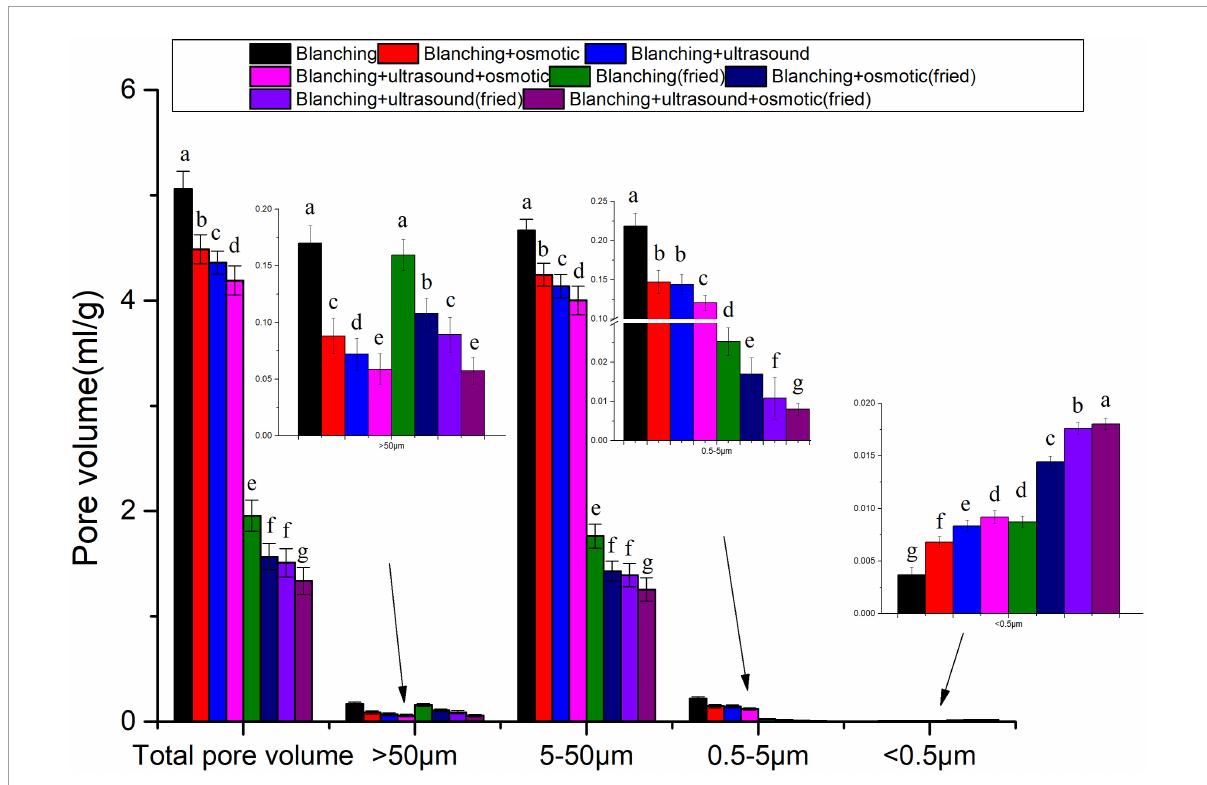
FIGURE3 Pore volume distribution of Pleurotus eryngii chips. Different superscript letters in the graph indicate significant differences between means ( P <